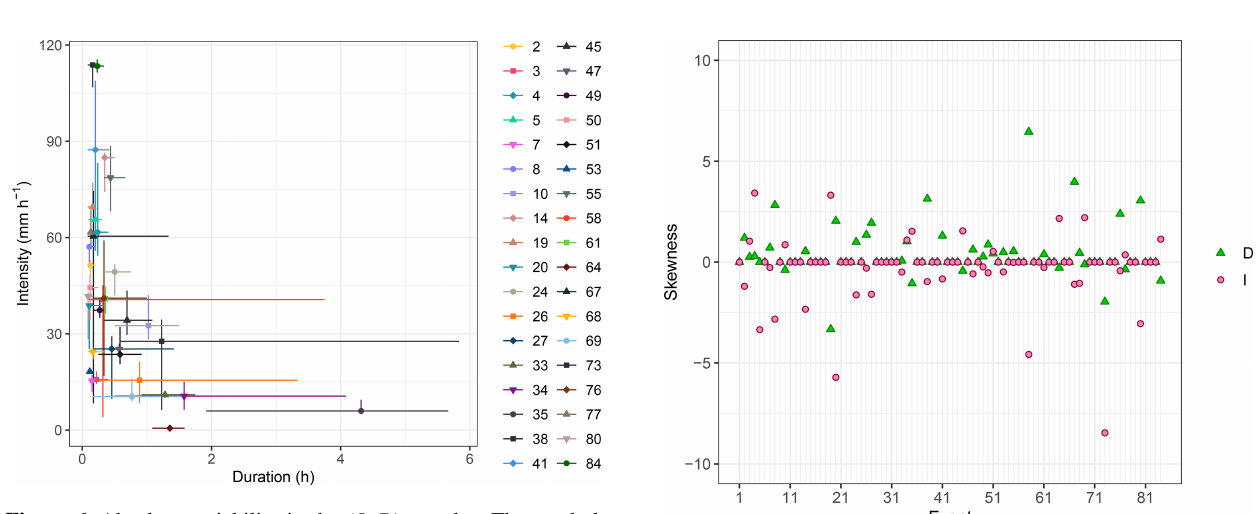
Figure 6. Absolute variability in the (I,D) couples. The symbols are the mean values, and the horizontal and vertical lines are re- spectively the duration and intensity variability ranges. To make the graph clearer, the events with ranges equal to zero have not been represented and the linear scale is used for both axes.